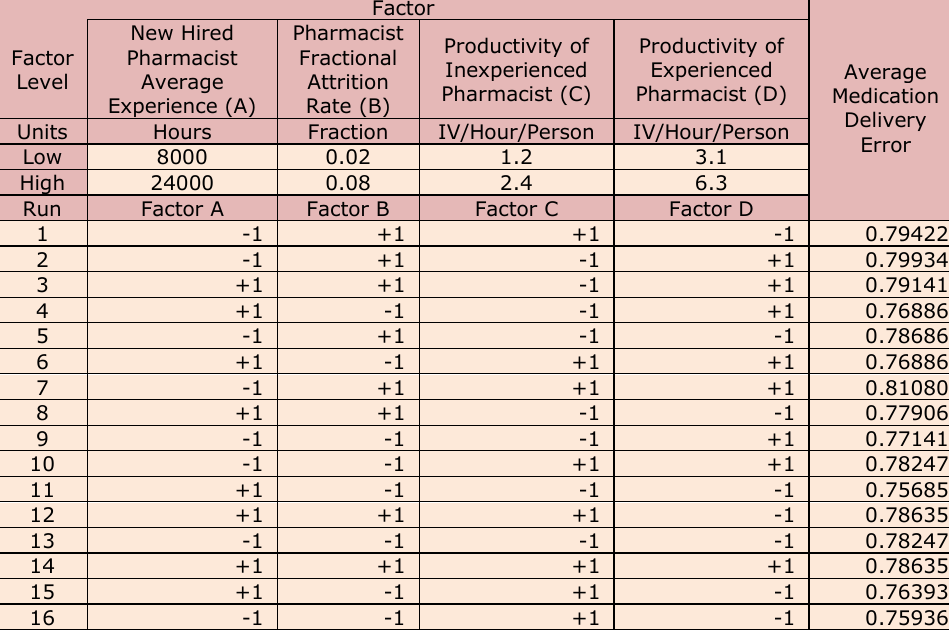
Table 4. Values for the medication delivery error parameters in the experimental design and formation and results of the medication delivery error experimental